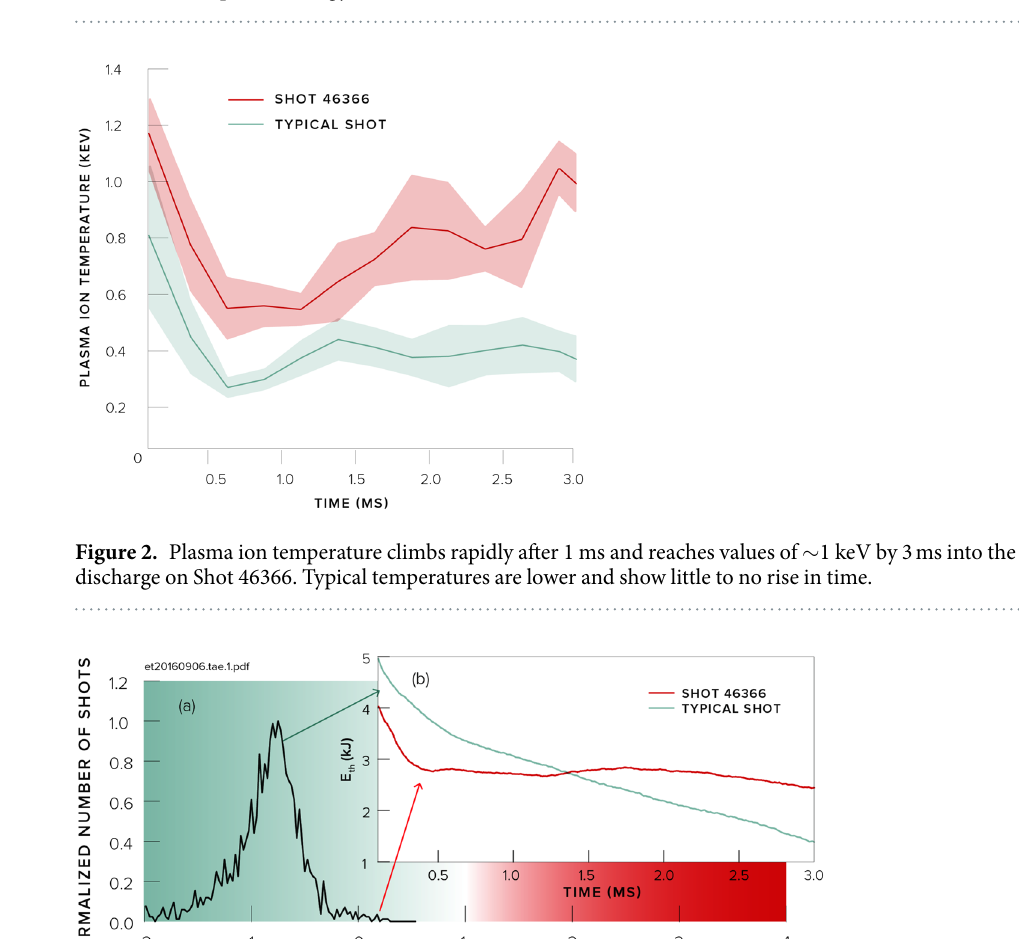
Table 1. Average plasma parameters at 1.5 ms within the plasma radius from Shot 46366 as well as a ‘typical’ shot. This typical shot (47778) is the median of the distribution shown in Fig. 3 and has the most common time evolution of the plasma energy.